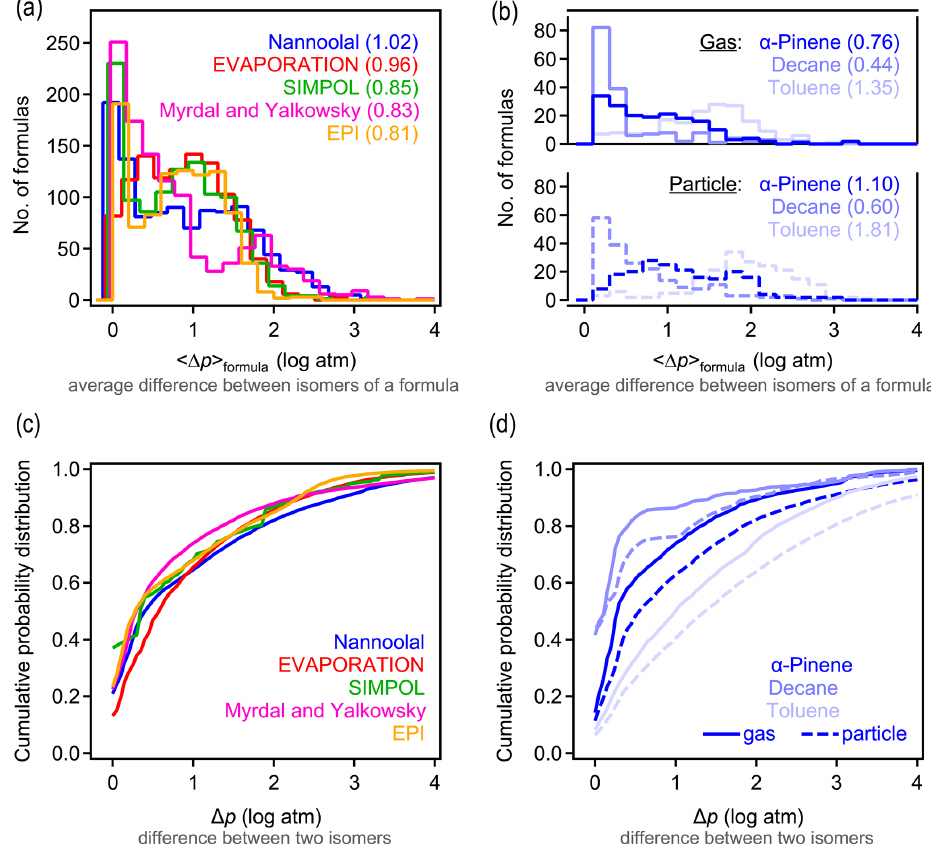
Figure 1. Differences in vapor pressure between isomers. (a) Distribution of (cid:104) (cid:49)p (cid:105) formula , the average difference between vapor pressures of isomers of a given formula for the five structure-based estimation methods examined, with (b) the same distribution broken out by oxidation system for the Nannoolal method. Average values of each distribution are provided in parentheses. (c) Cumulative probability distribution of (cid:49)p , the difference between any two isomers of a given formula for the five structure-based estimation methods examined, with (d) the same distribution broken out by the oxidation system for the Nannoolal method. The other four methods are shown in Figs.